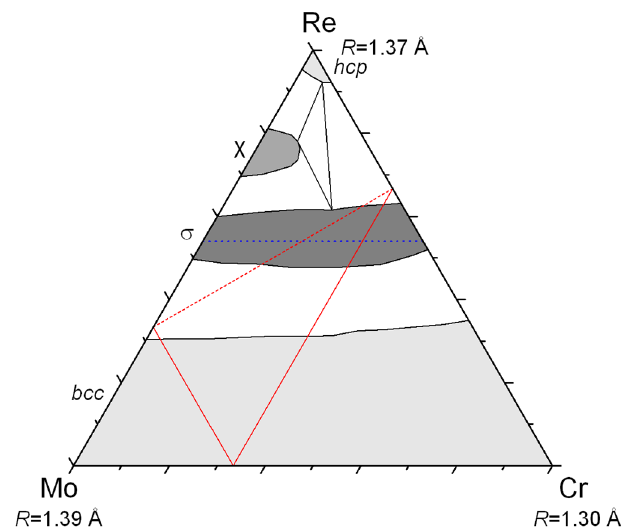
Figure 10. Isothermal section at 1150 °C of the Mo–Re–Cr system (redrawn from [23], Copyright 1999, Elsevier Science). The red triangle shows the three ordered stable or metastable compositions of the σ phase, Mo 2 Re, Mo 2 Cr, and Re 2 Cr, as in Figure 2 (solid lines: normal substitution, dashed line: site reversal). The site occupancies of Figure 10 are calculated along the blue line.